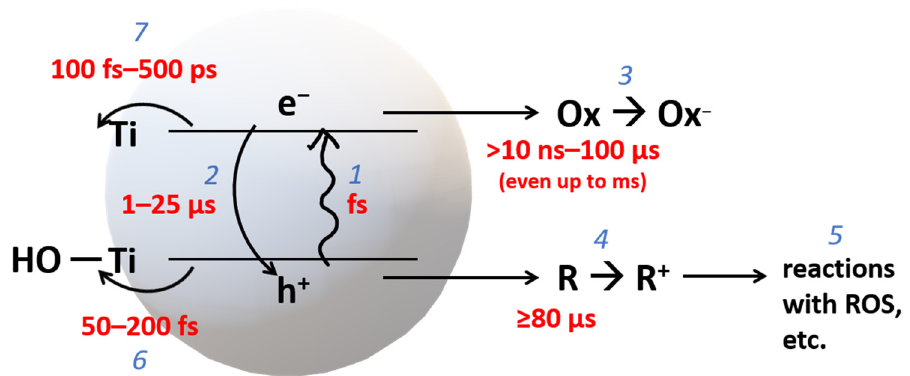
Figure 1. The core steps in photocatalytic mechanism include (1) absorption of light which forms charge carriers, (2) recombination of charge carriers, (3) reductive process with electrons in the conduction band (CB), (4) oxidative pathway undertaken by a valence-band (VB) hole, (5) further reactions (hydrolysis, reactions with reactive oxygen species (ROS), etc.), (6) trapping a VB hole at a Ti-OH group on the surface, and (7) trapping of CB electron at a Ti(IV) site to produce Ti(III). Redrawn from ref. [26] to include timescales obtained from [22–26]. The timescale in 3 and 4 are mainly from nontrapped electrons and holes (i.e., directly from the CB and VB).